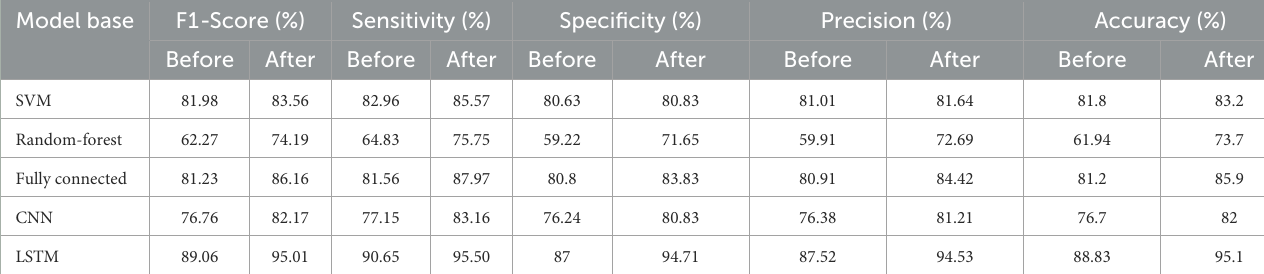
TABLE 3 Results of each model before and after augmentation data. Model base F1-Score (%) Sensitivity (%) Specificity (%) Precision (%) Accuracy (%) Before After Before After Before After Before After Before After